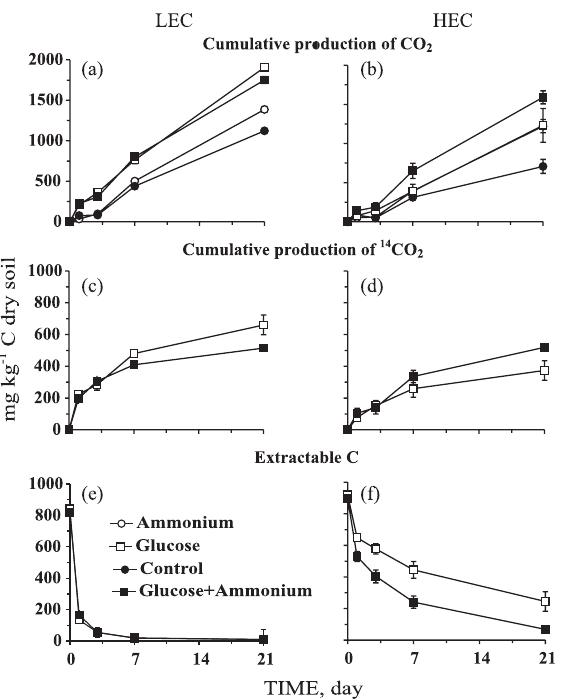
Figure 1. Cumulative production of 12 CO in (a) LEC 20 soil and (b) HEC soil, cumulative production of 14 CO in (c) LEC soil and d) HEC soil and 2 extractable 14 C in (e) LEC soil and (f) HEC soil unamended ( ) or amended with 200 mg kg -1 NH 4+ -N dry soil ( ), 1,000 mg kg -1 14 C-labeled + - glucose C dry soil ( ) or with 200 mg kg -1 NH 4 N dry soil plus 1,000 mg kg -1 14 C-labeled glucose C dry soil ( ) incubated aerobically at 22 ± 2 °C for 21 days. Bars are ± 1 STD and each point is the mean of n =